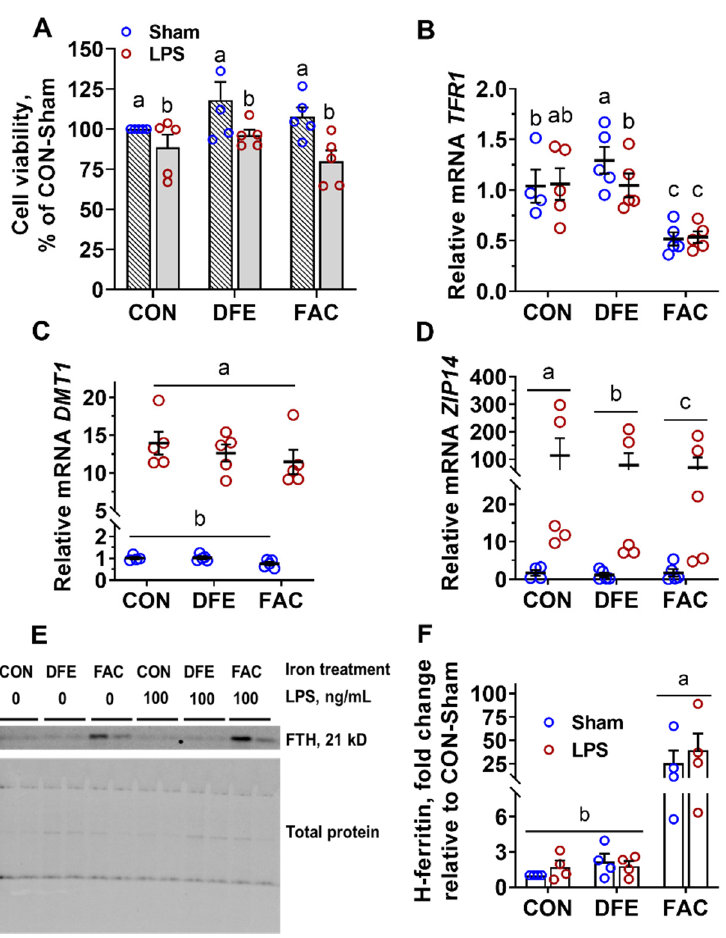
Figure 1. Effects of LPS (100 ng/mL, 6 h) challenge on cell viability and iron metabolism of PAMs pre-exposed to deferiprone (DFE, 500 µM, 24 h) or ferric ammonium citrate (FAC, 200 µM, 24 h). ( A ) LPS reduced cell viability independent of cellular iron status ( P Fe = 0.11, P LPS = 0.001, P Fe × LPS = 0.49). ( B ) Iron deprivation increased, whereas iron excess decreased, TFR1 mRNA expression ( P Fe < 0.001, P LPS = 0.15, P Fe × LPS = 0.04). ( C ) LPS markedly increased DMT1 mRNA expression ( P Fe = 0.07, P LPS < 0.001, P Fe × LPS = 0.17). ( D ) Iron imbalance decreased and LPS increased ZIP14 mRNA expression ( P Fe = 0.004, P LPS < 0.001, P Fe × LPS = 0.44). ( E ) Sample image of H-ferritin (FTH) immunoblot. ( F ) Iron overexposure increased FTH protein expression in PAMs ( P Fe < 0.001, P LPS = 0.42, P Fe × LPS = 0.60). Treatments sharing no common letter (a, b, c) are significantly different ( p <